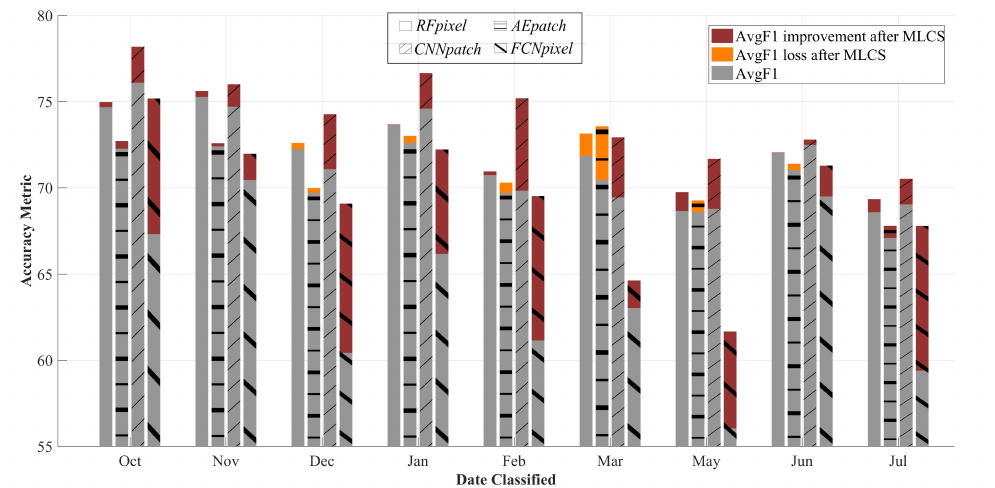
Figure 15. OA before and after MLCS algorithm. From left to right in each bar-group RFpixel , AEpatch , CNNpatch and FCNpixel repectively.